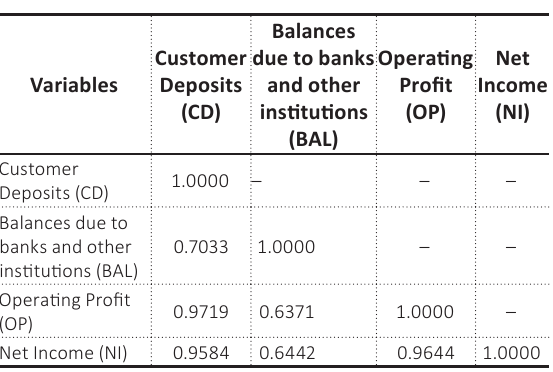
Table 3. Correlation